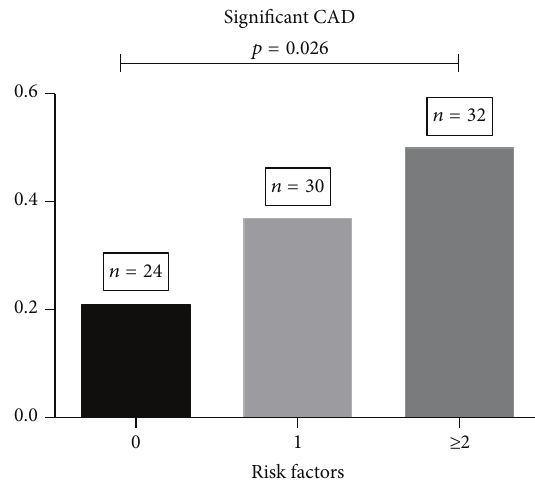
Figure 2: Incidence of CAD based upon number of risk factors that include age, hyperlipidemia, hypertension, family history of premature heart disease, diabetes, and obesity. CAD: coronary artery